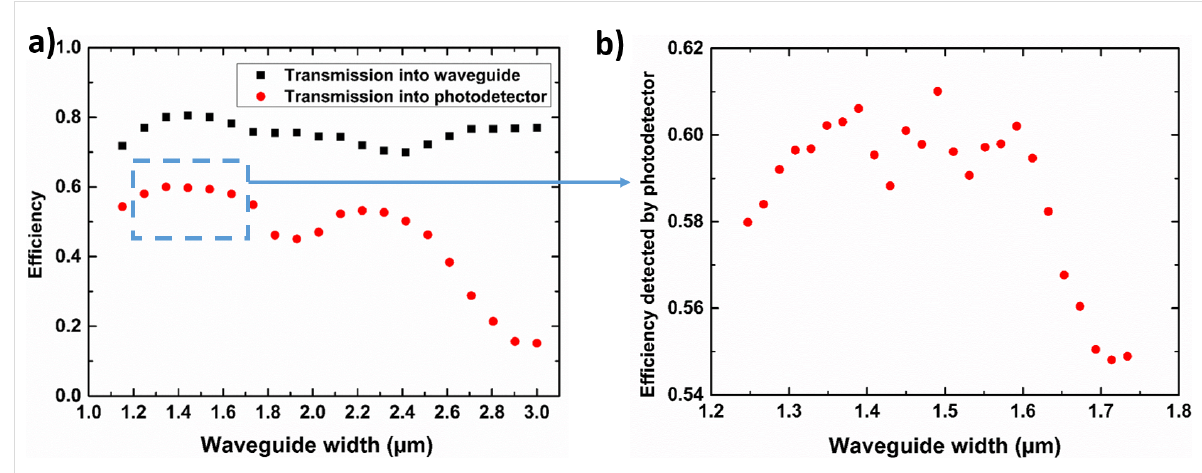
Figure 3: (a) Coupling efficiency from the LED to the waveguide (black squares) and from the LED to the detector (red circles) as a function of the waveguide width calculated with a step of 0.1 µm. (b) Coupling efficiency from the LED to the detector as a function of the waveguide width around the value of 1.5 µm calculated with a step of 22